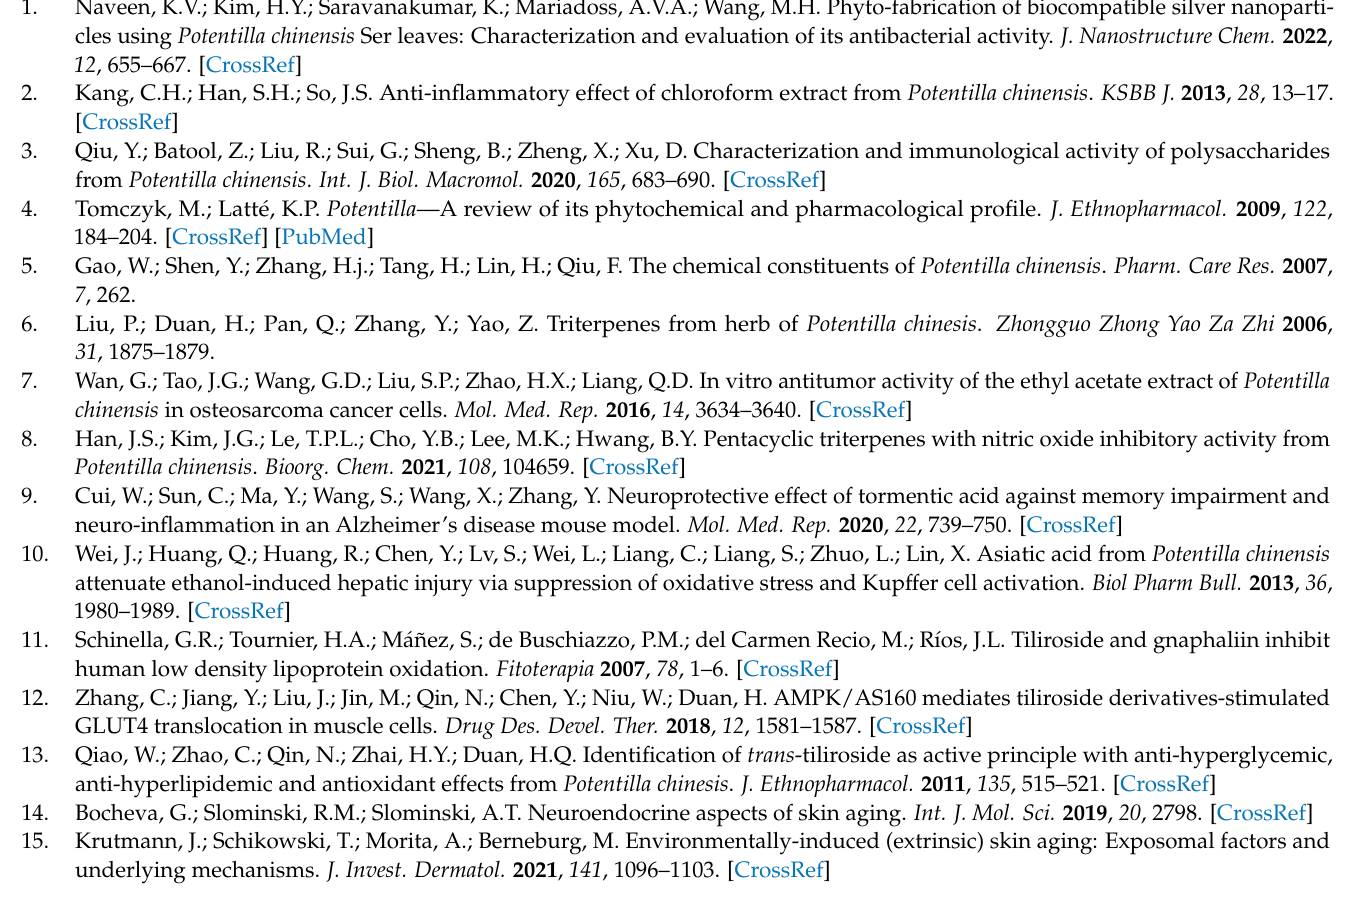
compound 1 ; Figure S7: The HMBC spectrum of compound 1 ; Figure S8: The ROESY spectrum of compound 1